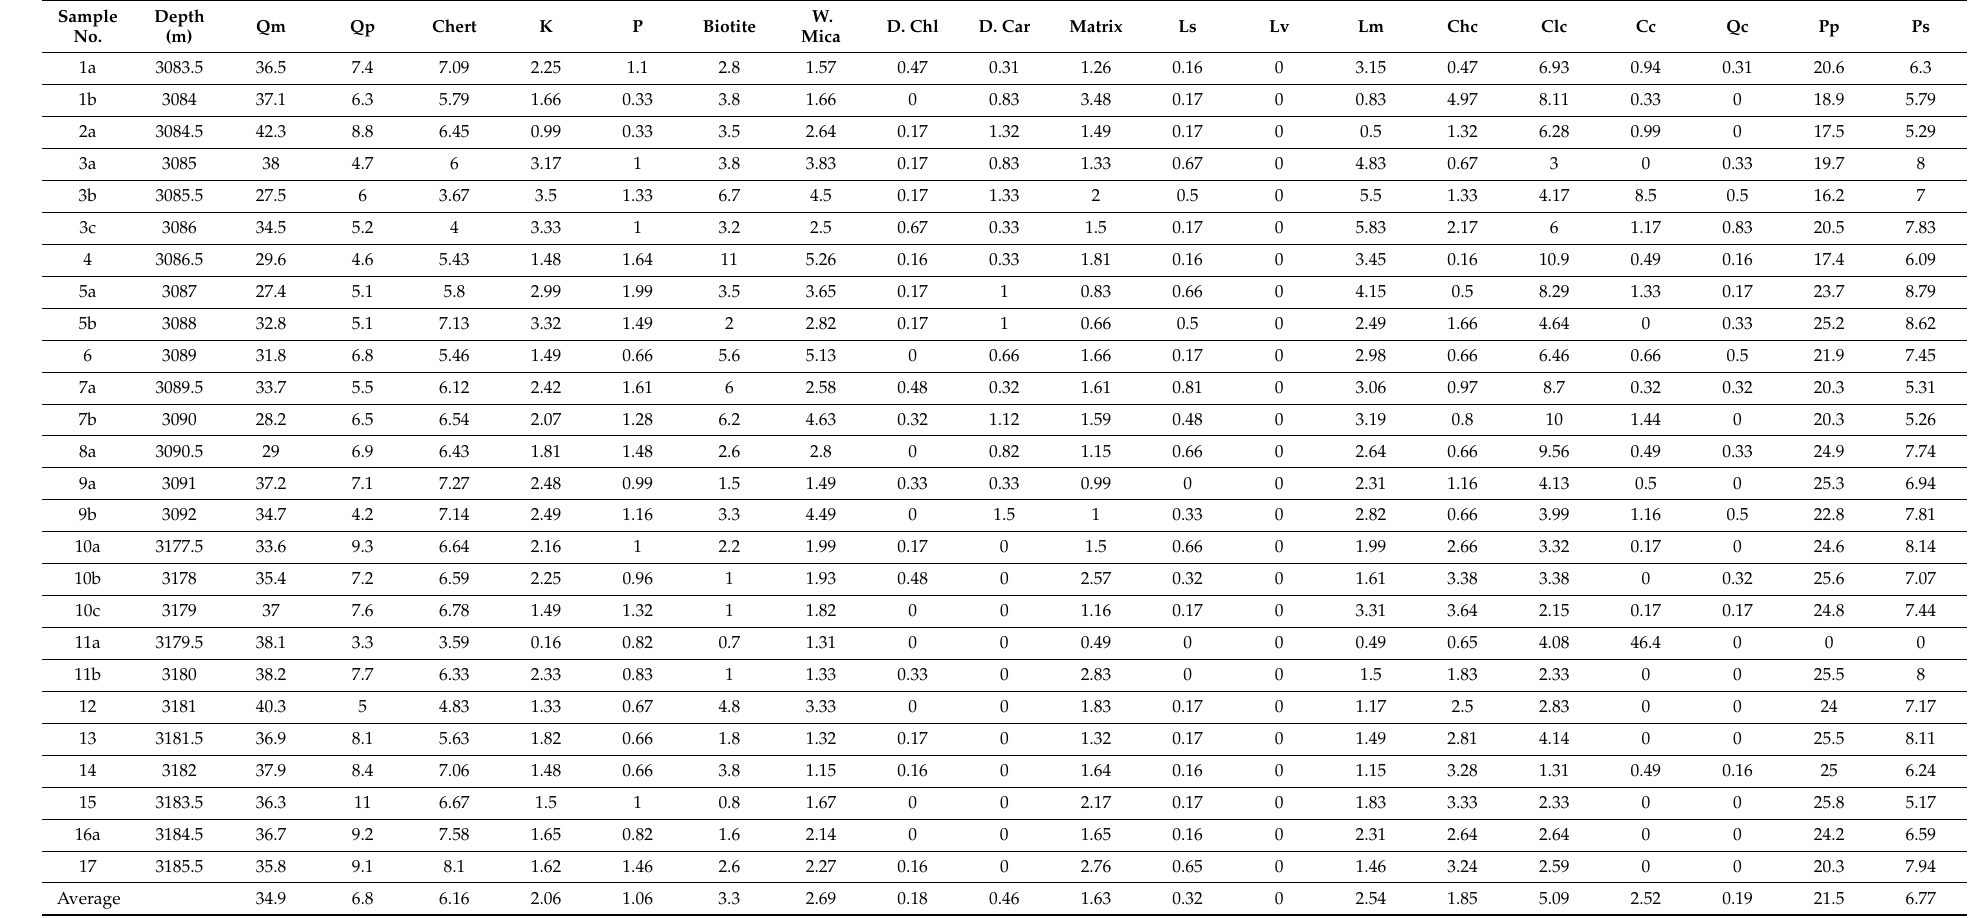
Table 2. Framework composition of the Neogene reservoir sandstones observed in the Srikail-3 well (expressed as percentage). Sample